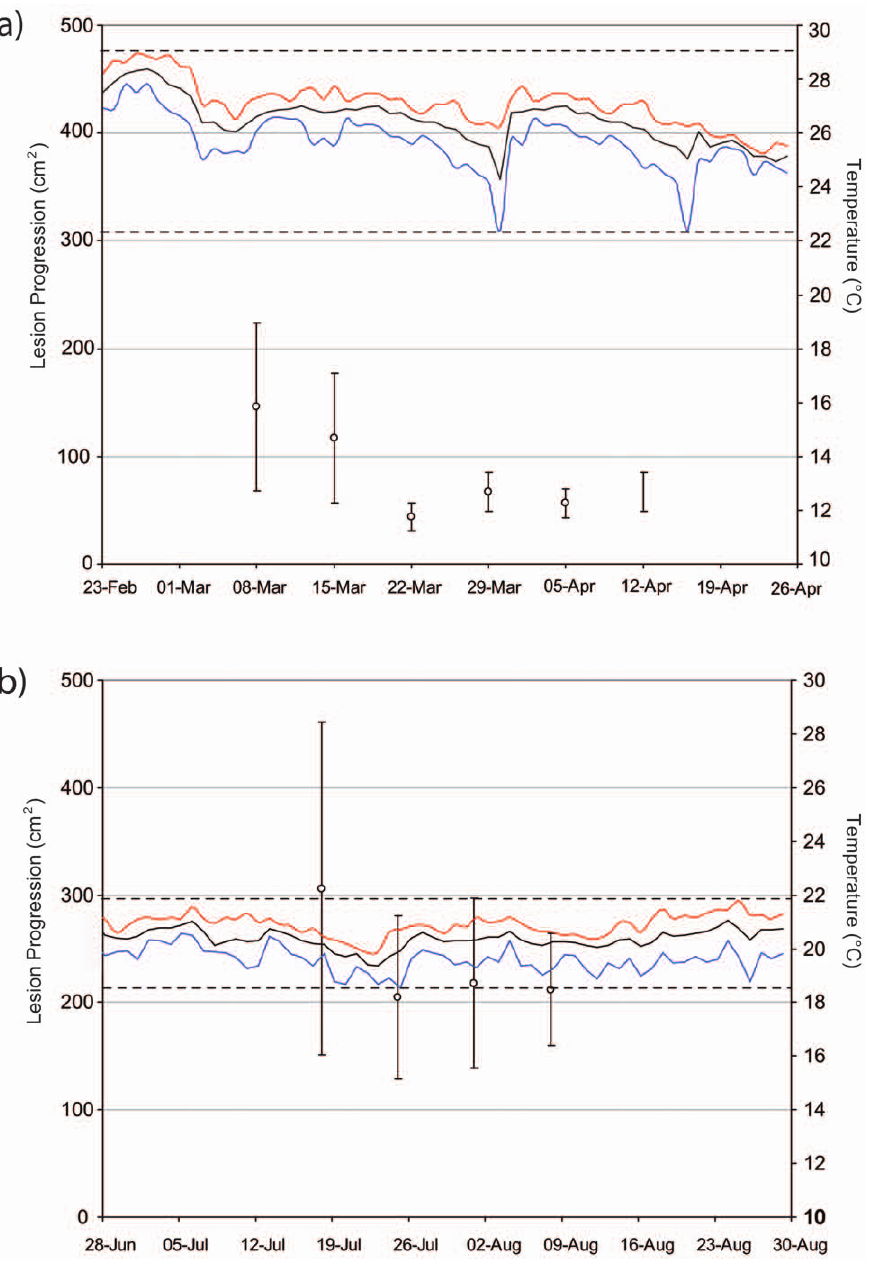
Figure 8. Temporal patterns of tissue loss in Acroporid white syndrome. Lesion progression (cm 2 2 6 SE) and average temperature ( u C 6 min/max) recorded during summer months (March–April) and winter months